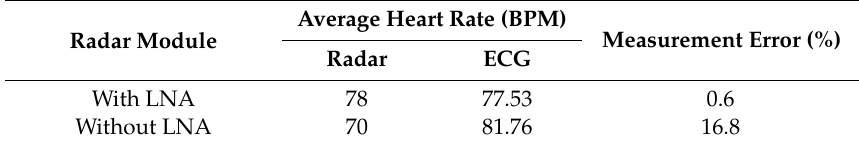
Table 4. Measured heart rates and error rates with and without on the proposed LNA in the radar sensor. Radar